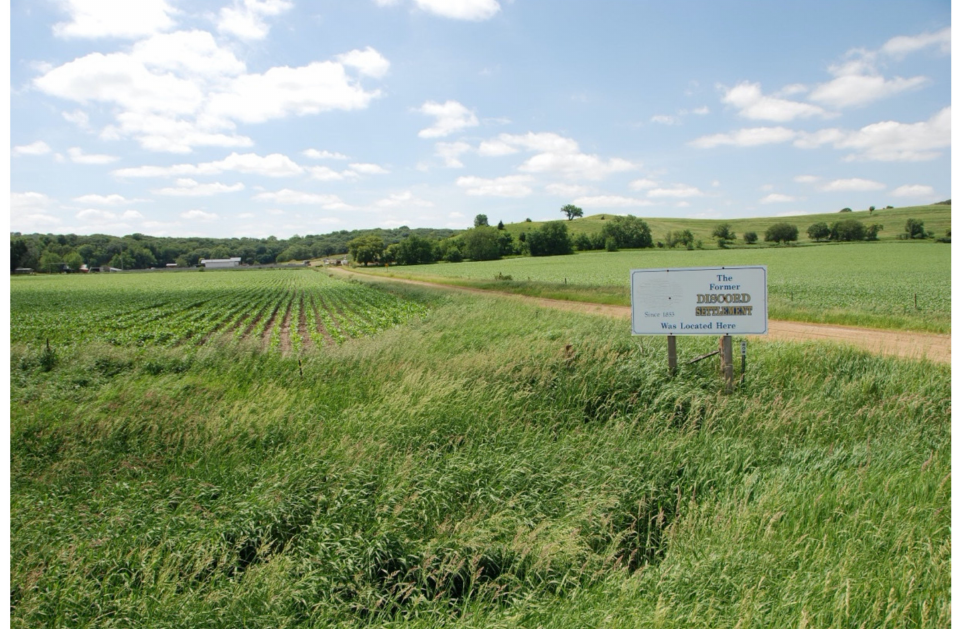
Figure 5. From transect across Northwest Iowa: Stage 1–In Memory. Abandoned settlement of Discord, Iowa.